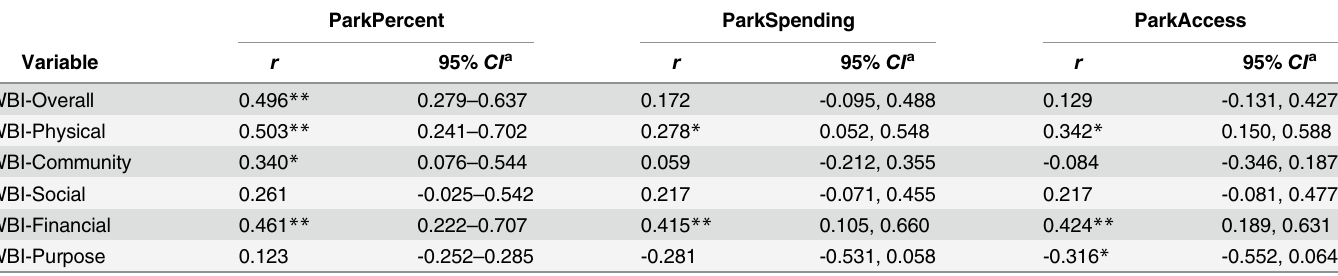
Table 2. Pearson Correlation Coefficients Examining Associations between Park Variables and Wellbeing Indicators for U.S. Cities (n =